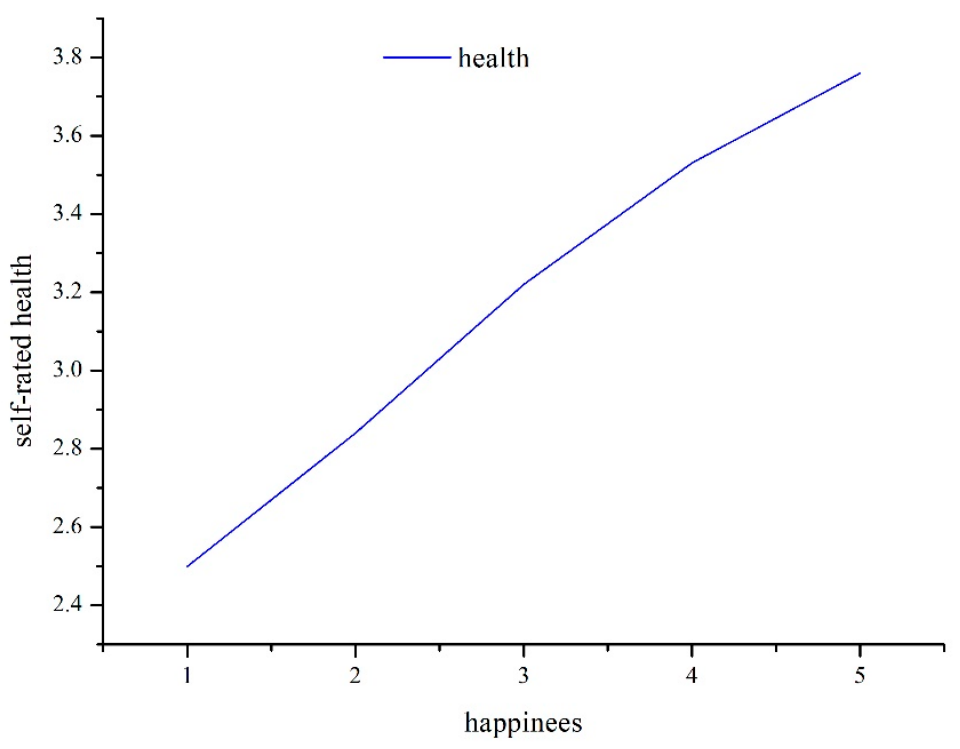
Figure 1. The change of self-rated health with happiness.